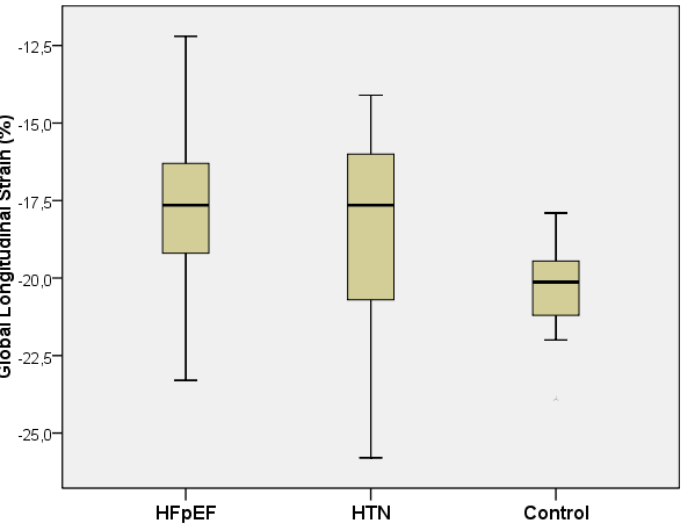
in the control group ( − 20.2 ± 1.4) compared with the HFpEF group ( − 17.6 ± 2.3) (Scheffe